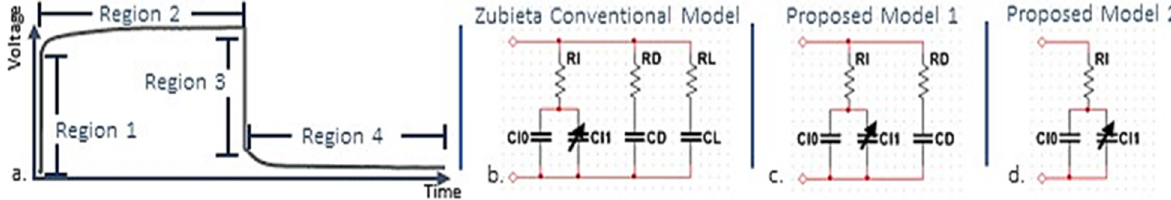
Figure 3. ( a ) Data regions used for parameter extraction shown on a representative curve. ( b ) Zubieta DLC model Equiv- alent Circuit. ( c ) Proposed Model 1 equivalent circuit implemented with bio-gel EDLC and EGOFET equivalent ( d ) Model 2 equivalent circuit implemented with OEGFET equivalent.